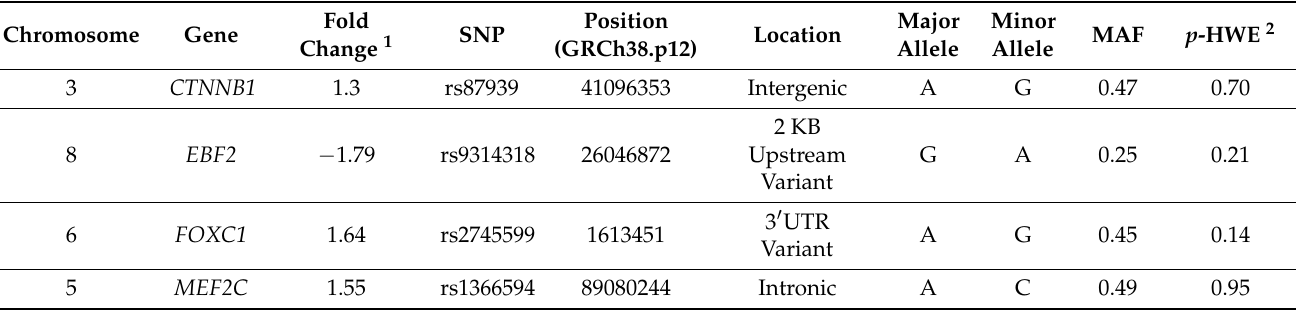
Table 1. Genes and SNPs